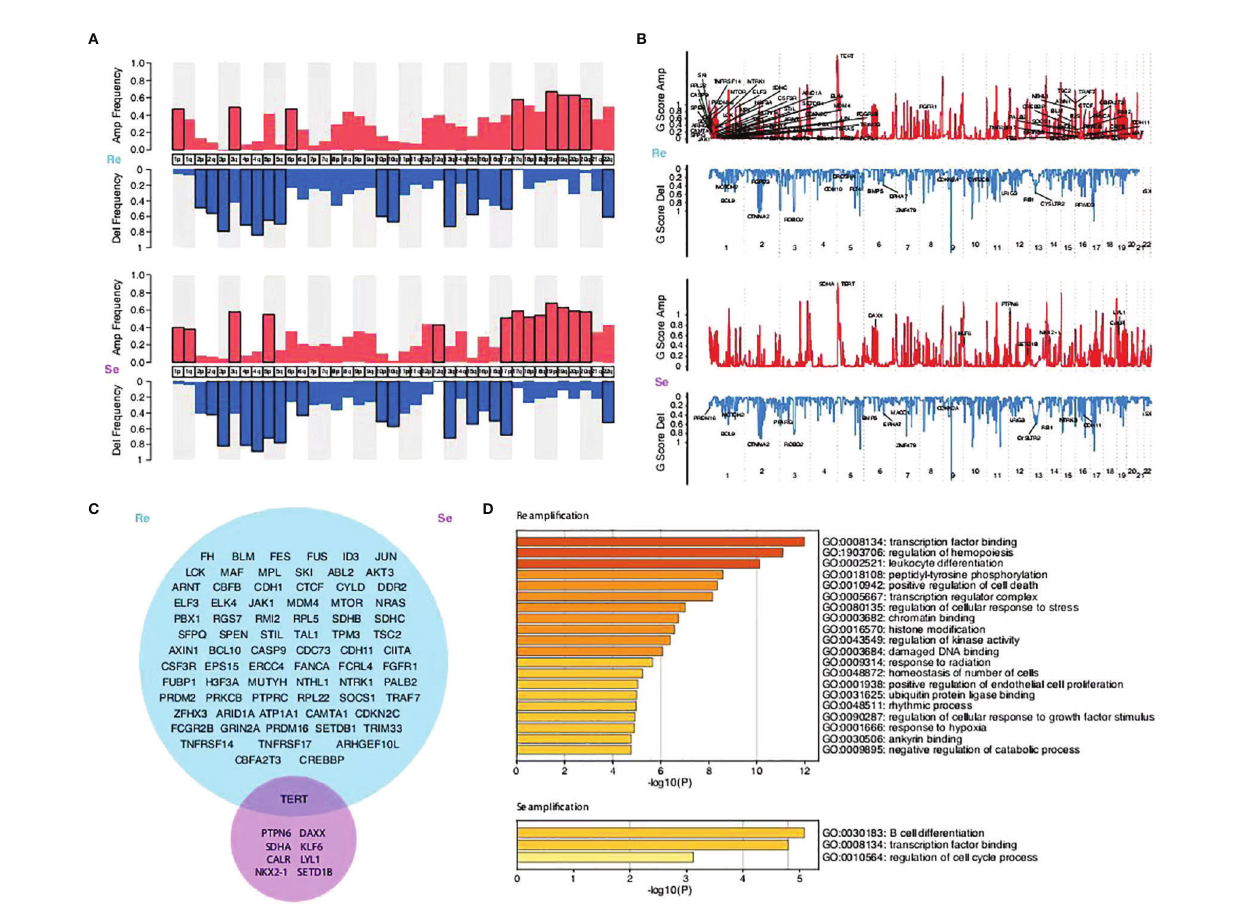
FIGURE 4 | Comparison of the copy number variations between the two groups and their enriched biological functions. (A) Ampli fi cation and deletion frequency of copy number variations (CNVs) on the chromosome arm level. (B) Scores of the signi fi cant ampli fi cation and deletion regions. (C) Venn graphs showing different ampli fi cation focal CNV genes between the two groups predicted by the GISTIC method (FDR q < 0.1). (D) KEGG pathways and GO functions enriched by focal CNV genes that signi fi cantly affected PFS